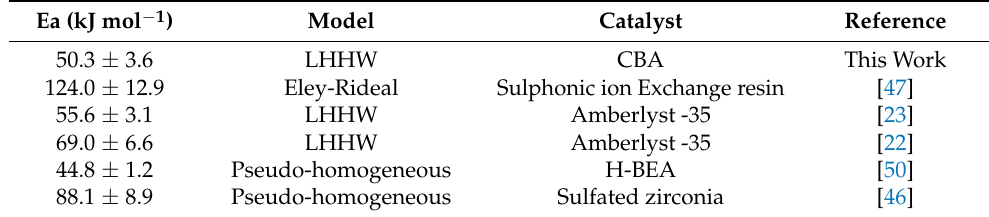
Table 8. Comparison of the activation energy values obtained by different